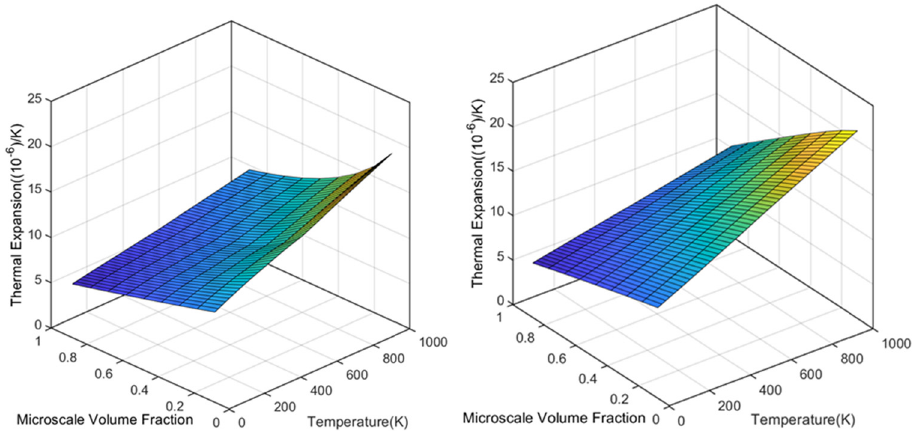
Figure 14: E ff ects of volume fraction of Nb 3 Sn fi lament at microscale and temperature on mesoscale homogenized thermal expansion coe ffi cients, ( Left ) α 11⁎ , ( Right ) α α 22⁎ 33⁎ ( ) .